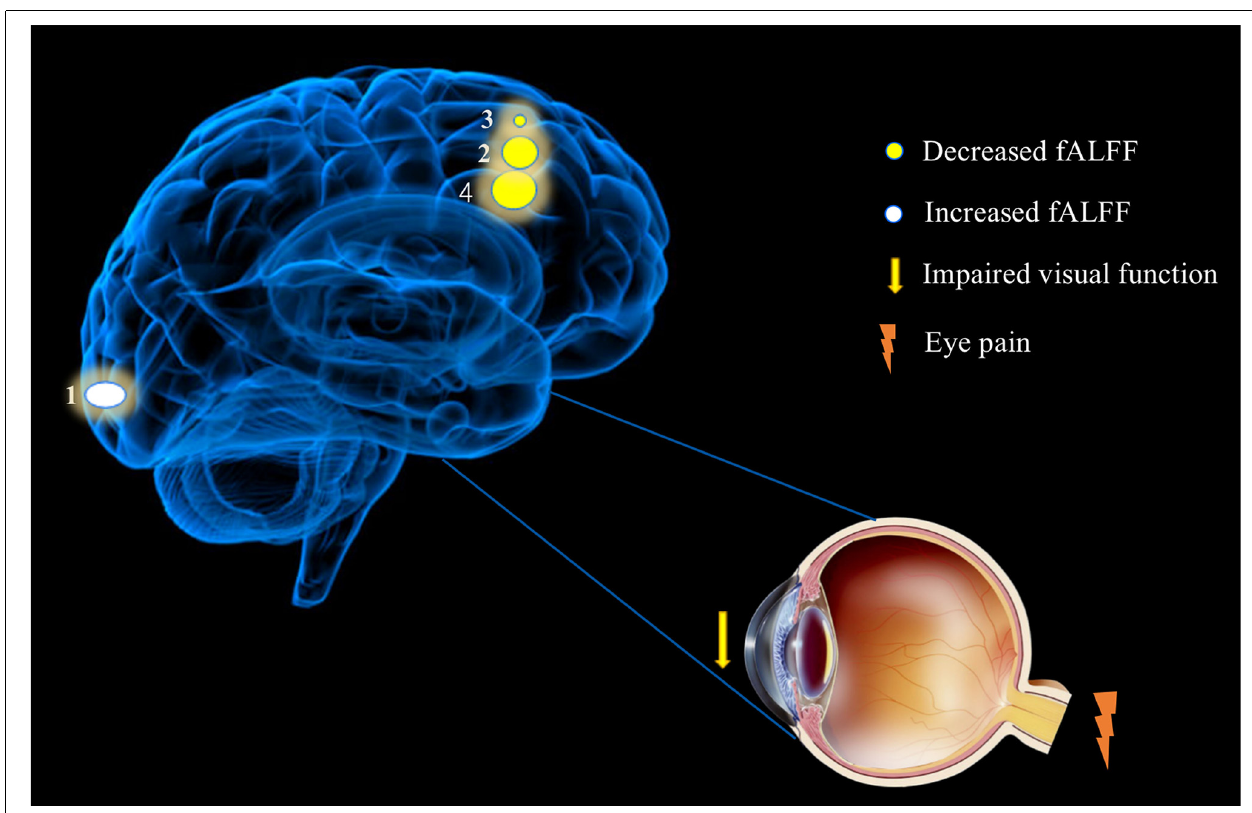
FIGURE 5 | Significant differences in spontaneous brain activity between the DE and HC groups. Different brain regions that were observed: (1) Calcarine_L (aal); (2) Frontal_Mid_R(aal); (3) Frontal_Mid_L(aal); (4) and Frontal_Mid_R(aal)/Frontal_Inf_Orb_R (aal). The white areas present brain regions with increased fALFF values and the yellow areas are brain regions with decreased fALFF values. Abbreviations: fALFF, fractional amplitude of low-frequency fluctuation; L, left; R, right; Calcarine_L (aal), calcarine sulcus; Frontal_Mid_L (aal), left middle frontal gyrus; Frontal_Mid_R (aal), right middle frontal gyrus; Frontal_Mid_R (aal)/Frontal_Inf_Orb_R (aal), right middle frontal gyrus/right inferior frontal